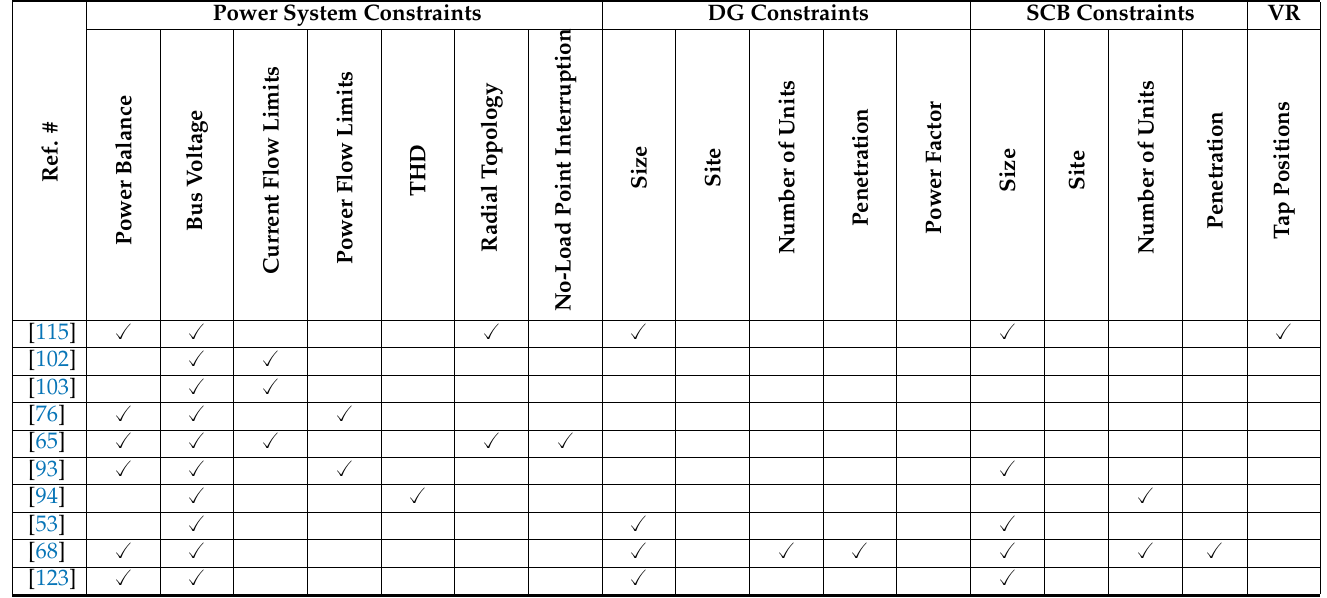
Table 3. Constraints employed in the existing studies for optimizing the simultaneous allocation of DG and SCB